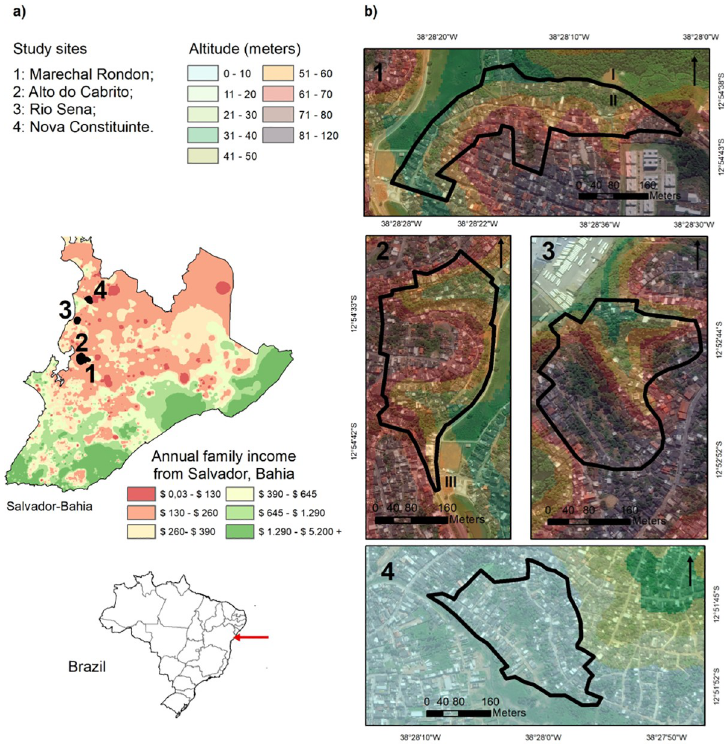
Fig 1. Map of the four study areas in the city of Salvador: a) showing the location of the communities within the city, annual income distribution in the city, b) altitude gradient within each community.